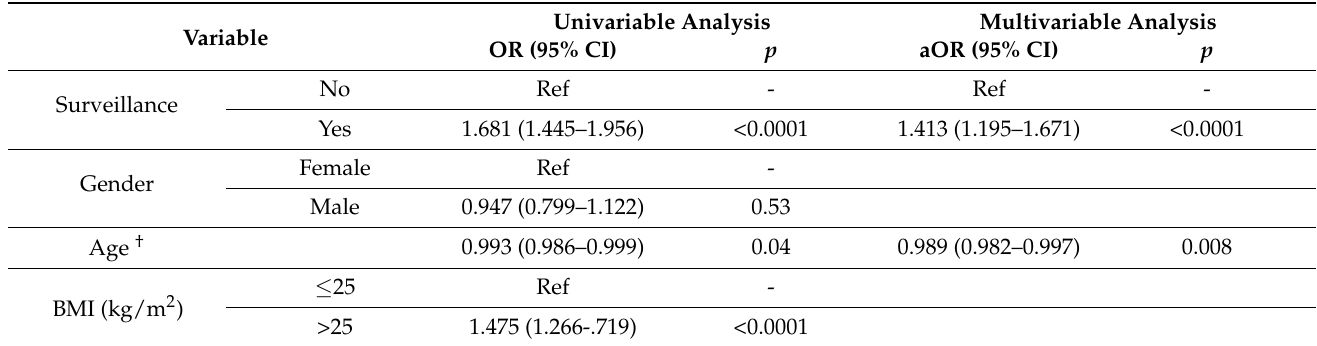
Table 2. Univariate and multivariate logistic regression analysis for independent predictors of long-term survivors (LS) group